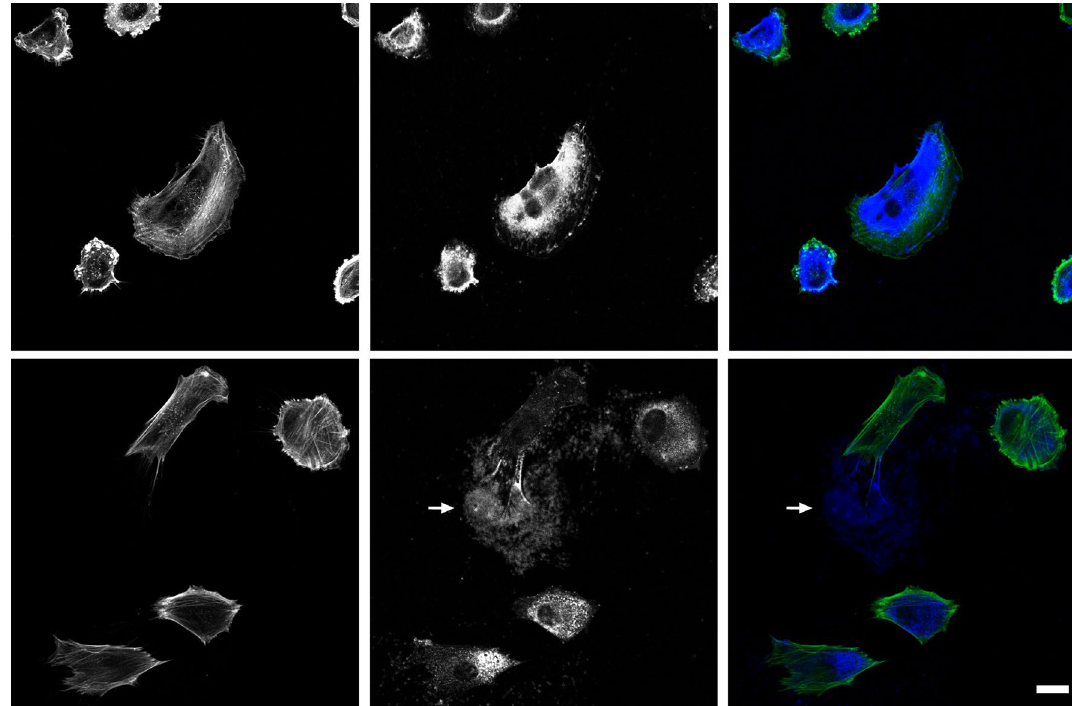
Figure 1. Spatial distribution of hyaluronan and F-actin in control and invasive fibroblasts. Images show normal Bjhtert (bottom) and Bj-invasive fibroblasts (top) with regards to the spatial distribution of F-actin (left) and hyaluronan (middle) and merged (right) columns. Arrows indicate extracellular hyaluronan trails. Scale bar: 20